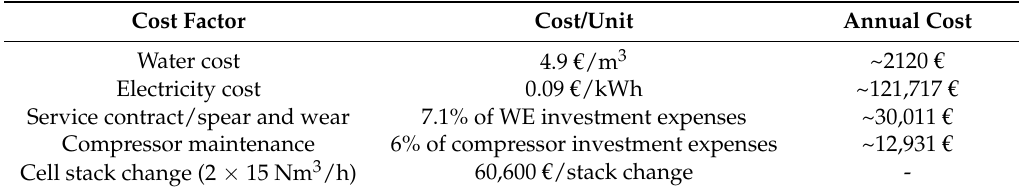
Table 5. Values of selected design variables for the selected utilization (18,896 kg/year).